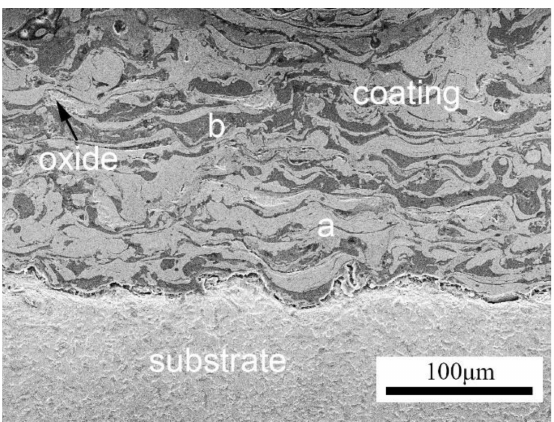
Figure 3. HVAS FeCrAl/Al coating microstructure: ( a ) FeCrAl splats and ( b ) Al splats. Reprinted with permission from ref.